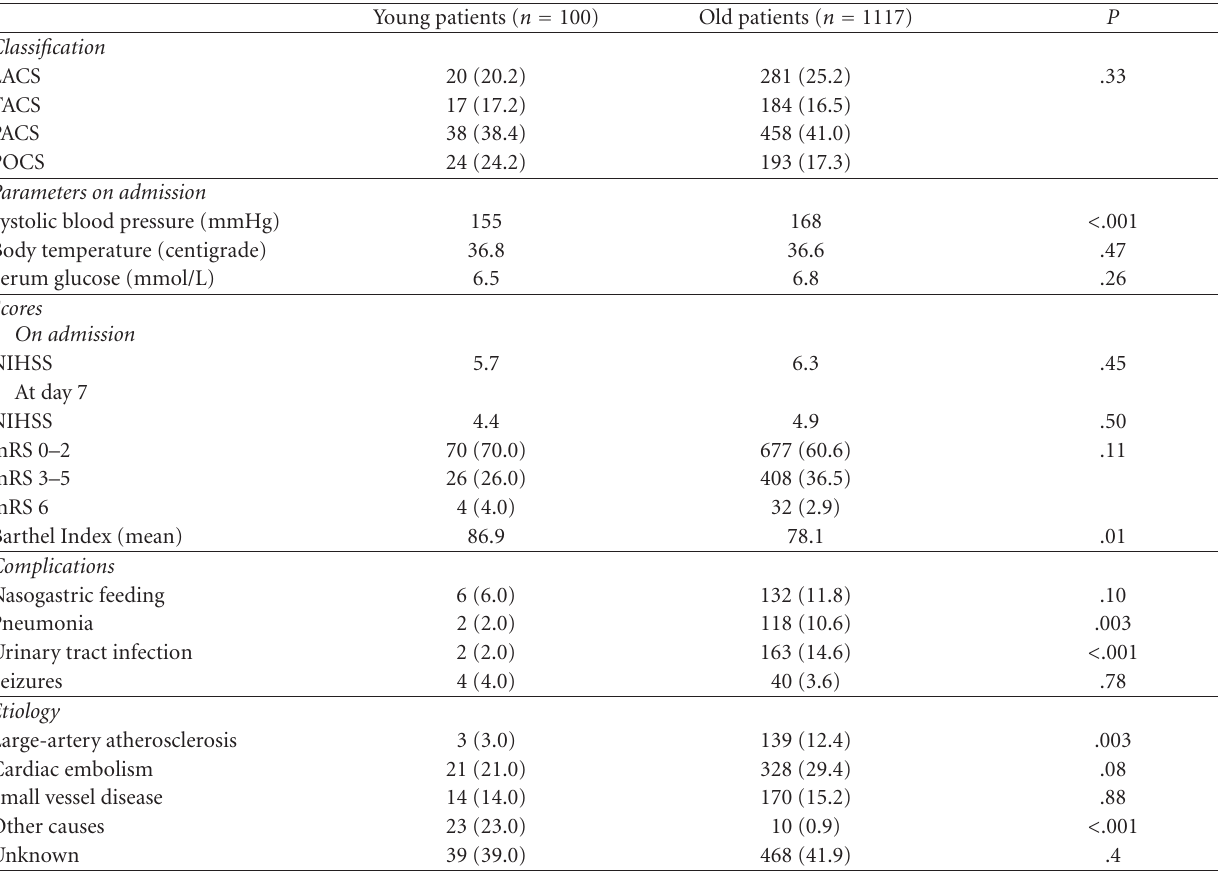
Table 2: Characteristics of cerebral infarction in young and old